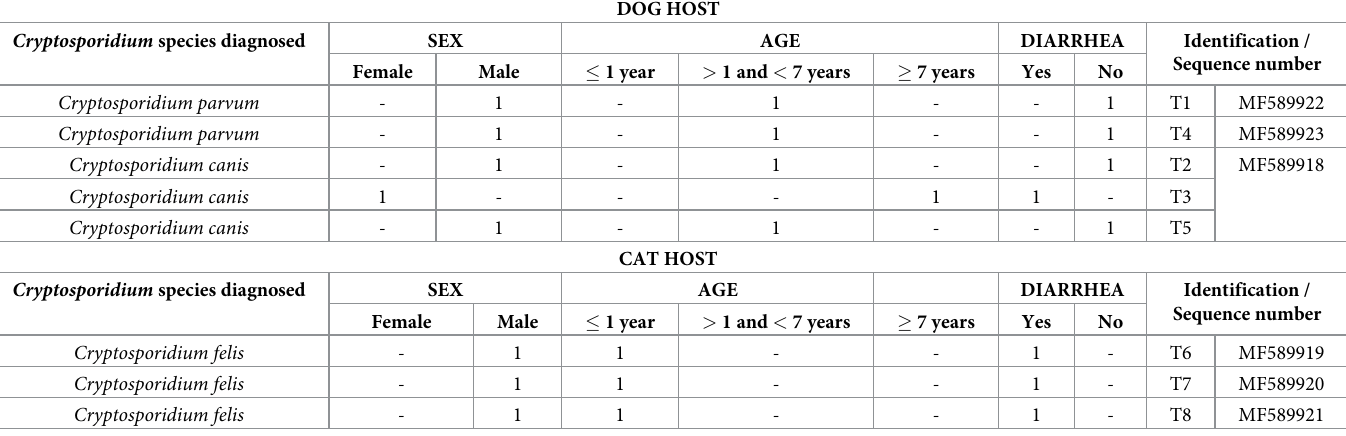
Table 3. Cryptosporidium spp. species and C . parvum subtype parasitizing the dogs and cats assessed according to sex, age, and presence and absence of diarrhea and the numbers of their respective sequences.